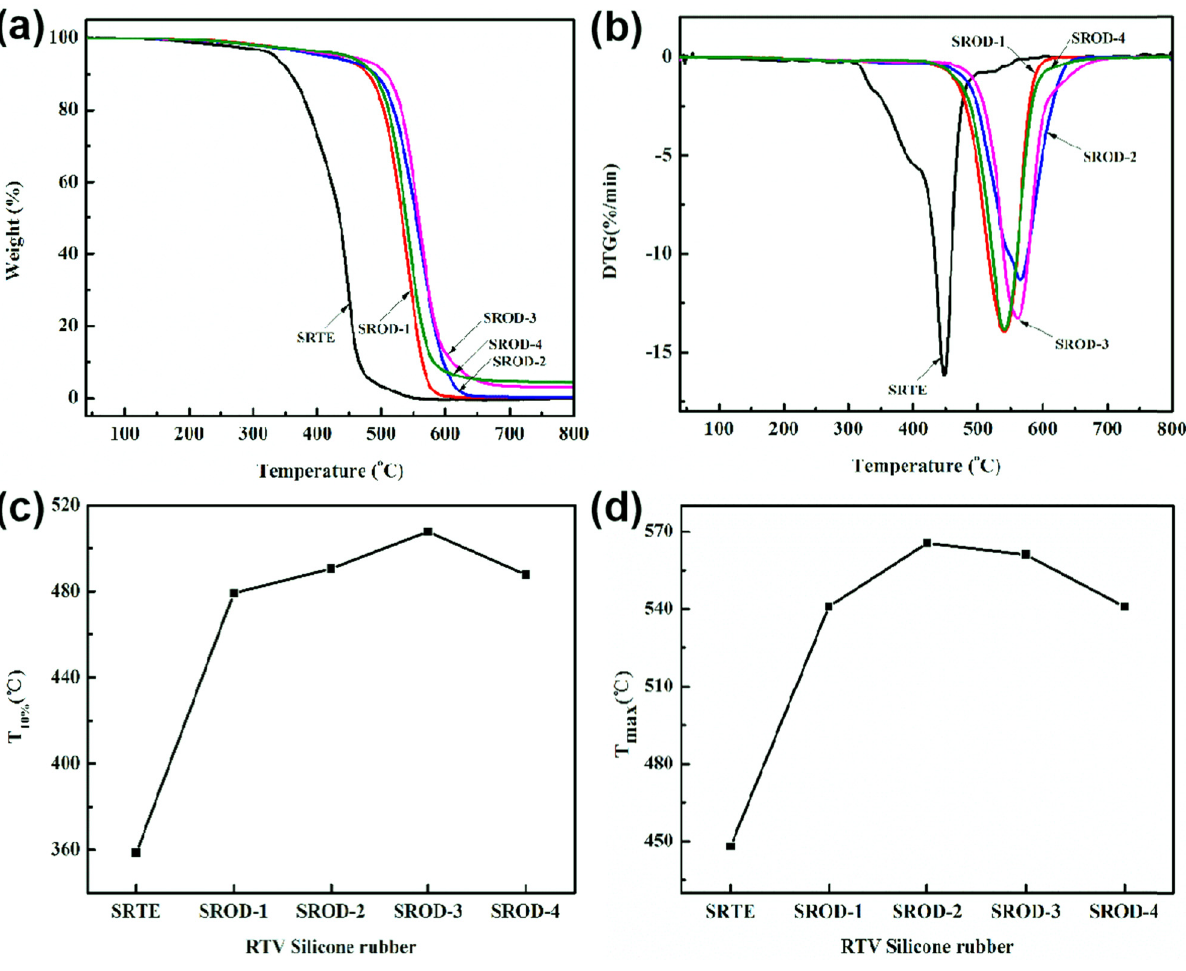
Figure 8: Thermal stabilities of RTV silicone rubber: ( a ) TG curves of RTV silicone rubber; ( b ) DTG curves of RTV silicone rubber; ( c ) T 10% of RTV silicone rubber; and ( d ) T max of RTV silicone rubber.